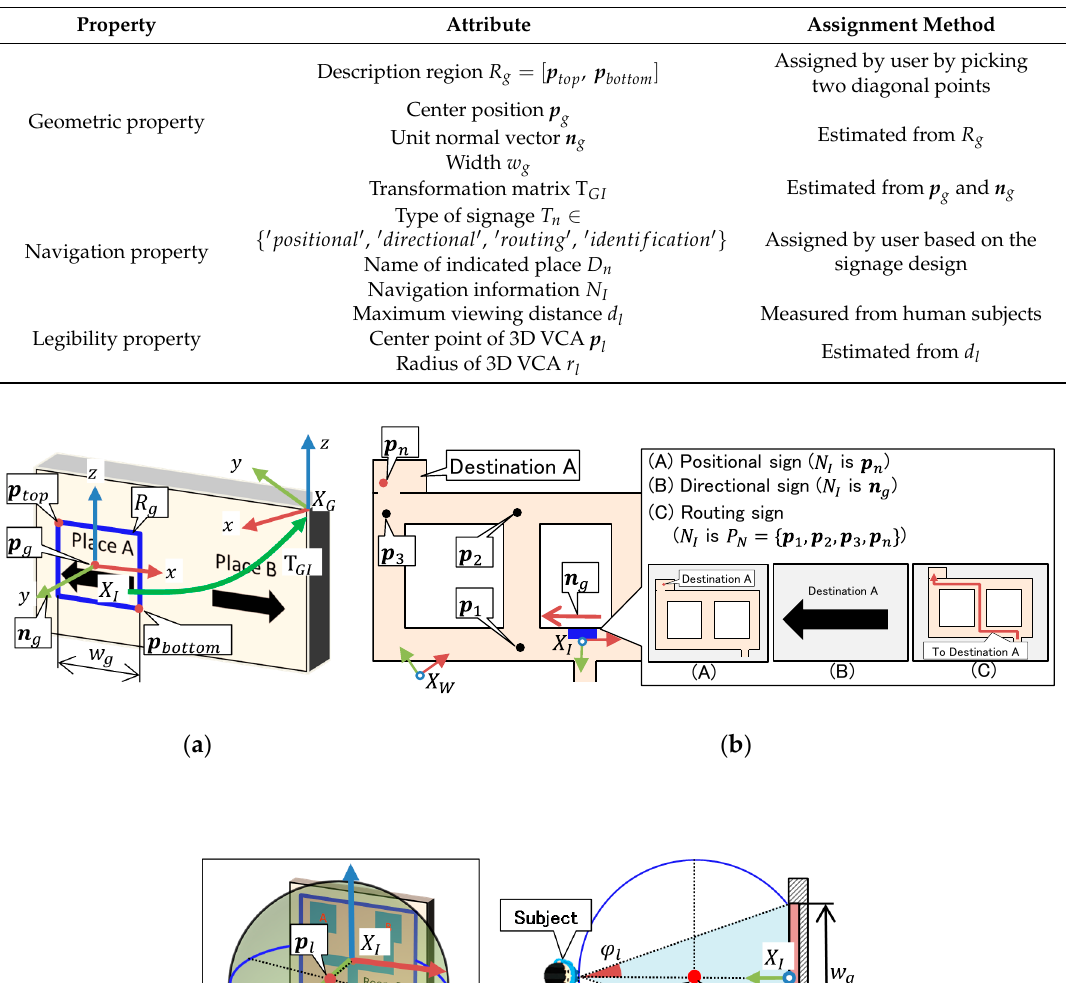
Table 2. Signage information entity.